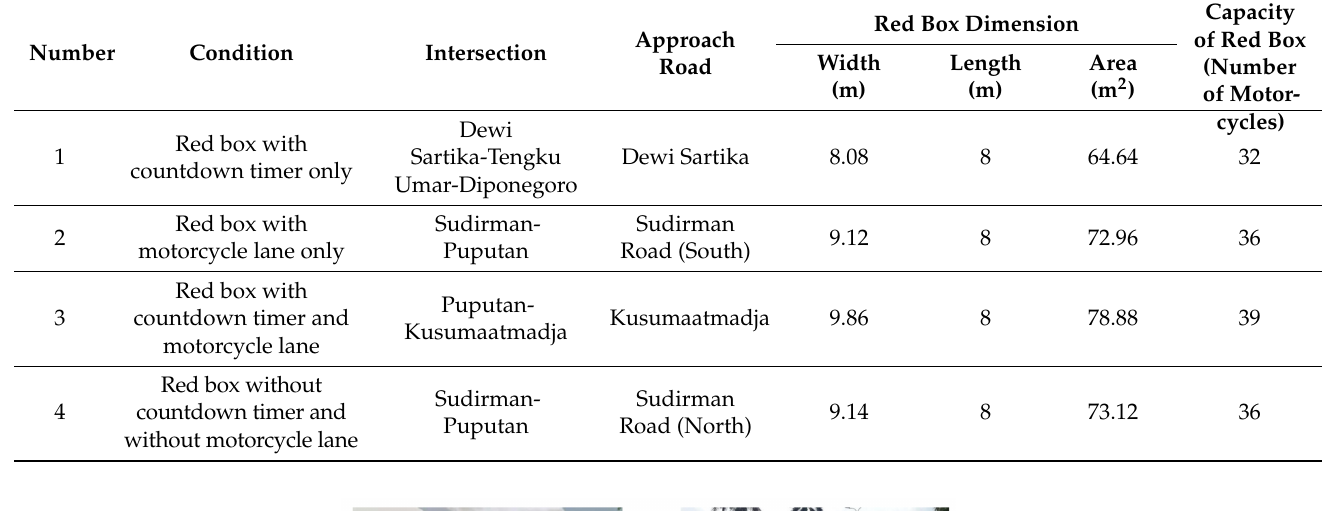
Table 1. Four conditions of red boxes for motorcycles at signalized intersection.